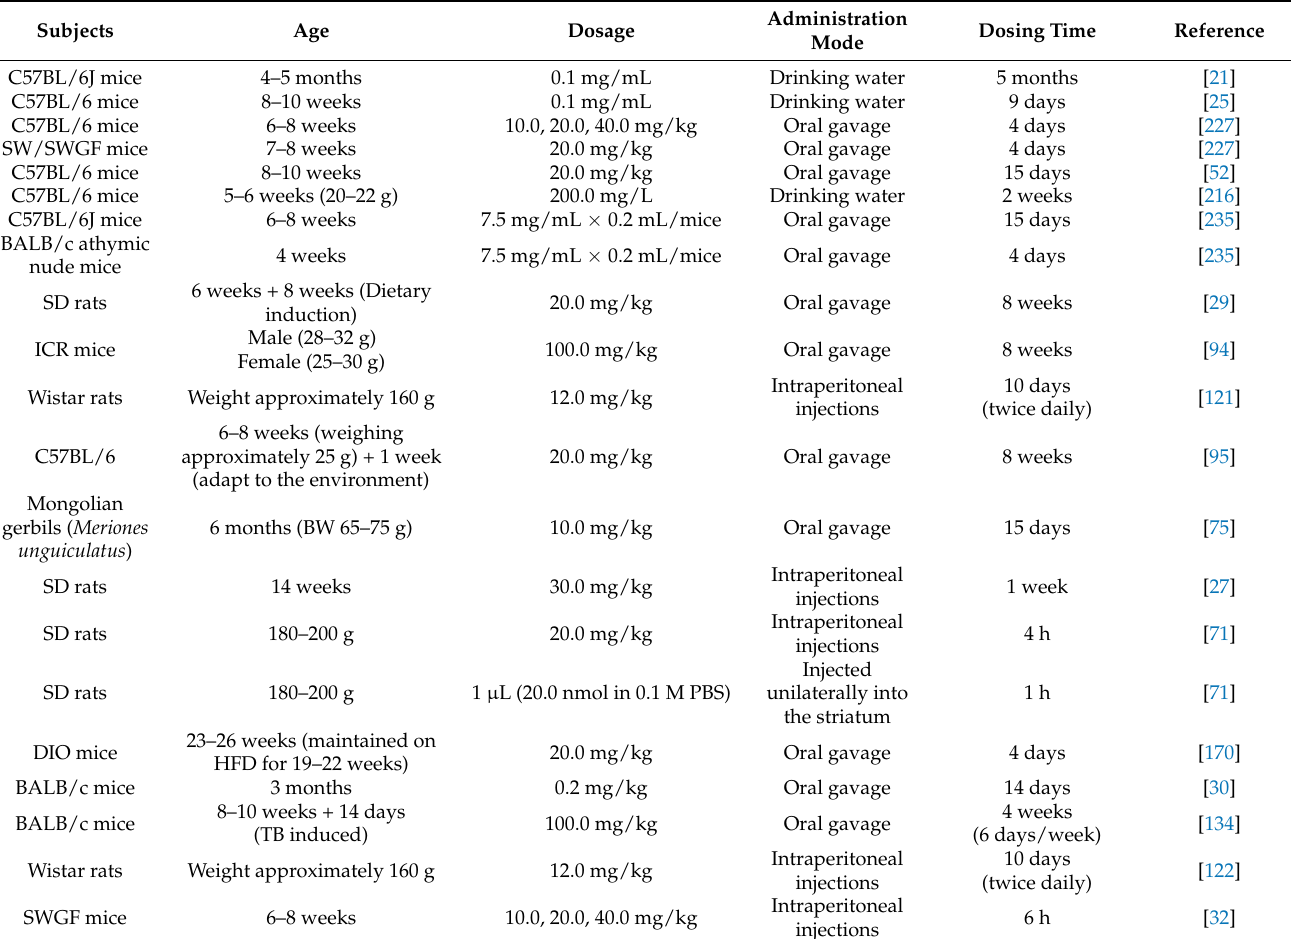
Table 3. Dosage and administration time of IPA in mouse